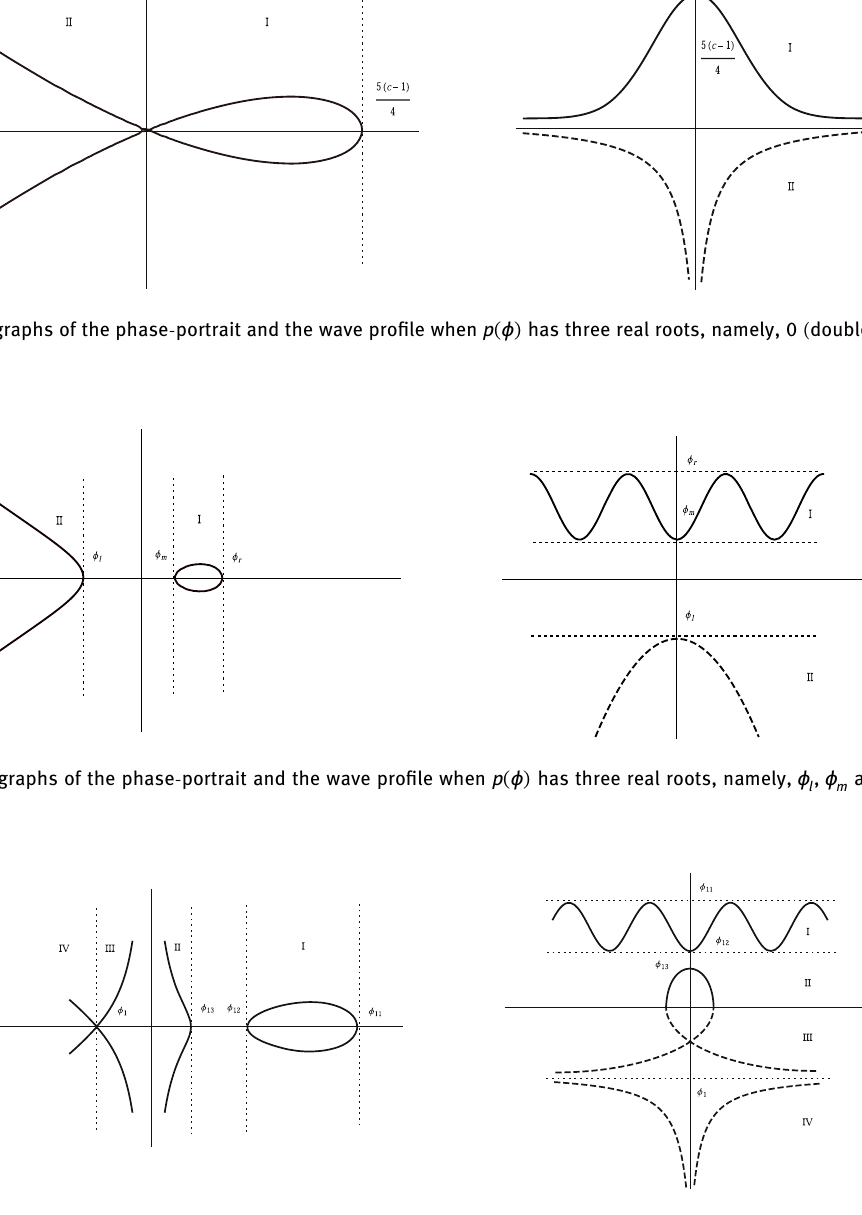
Figure 3: The graphs of the phase - portrait and the wave pro fi le when ( ) P ϕ has a double negative root ϕ roots